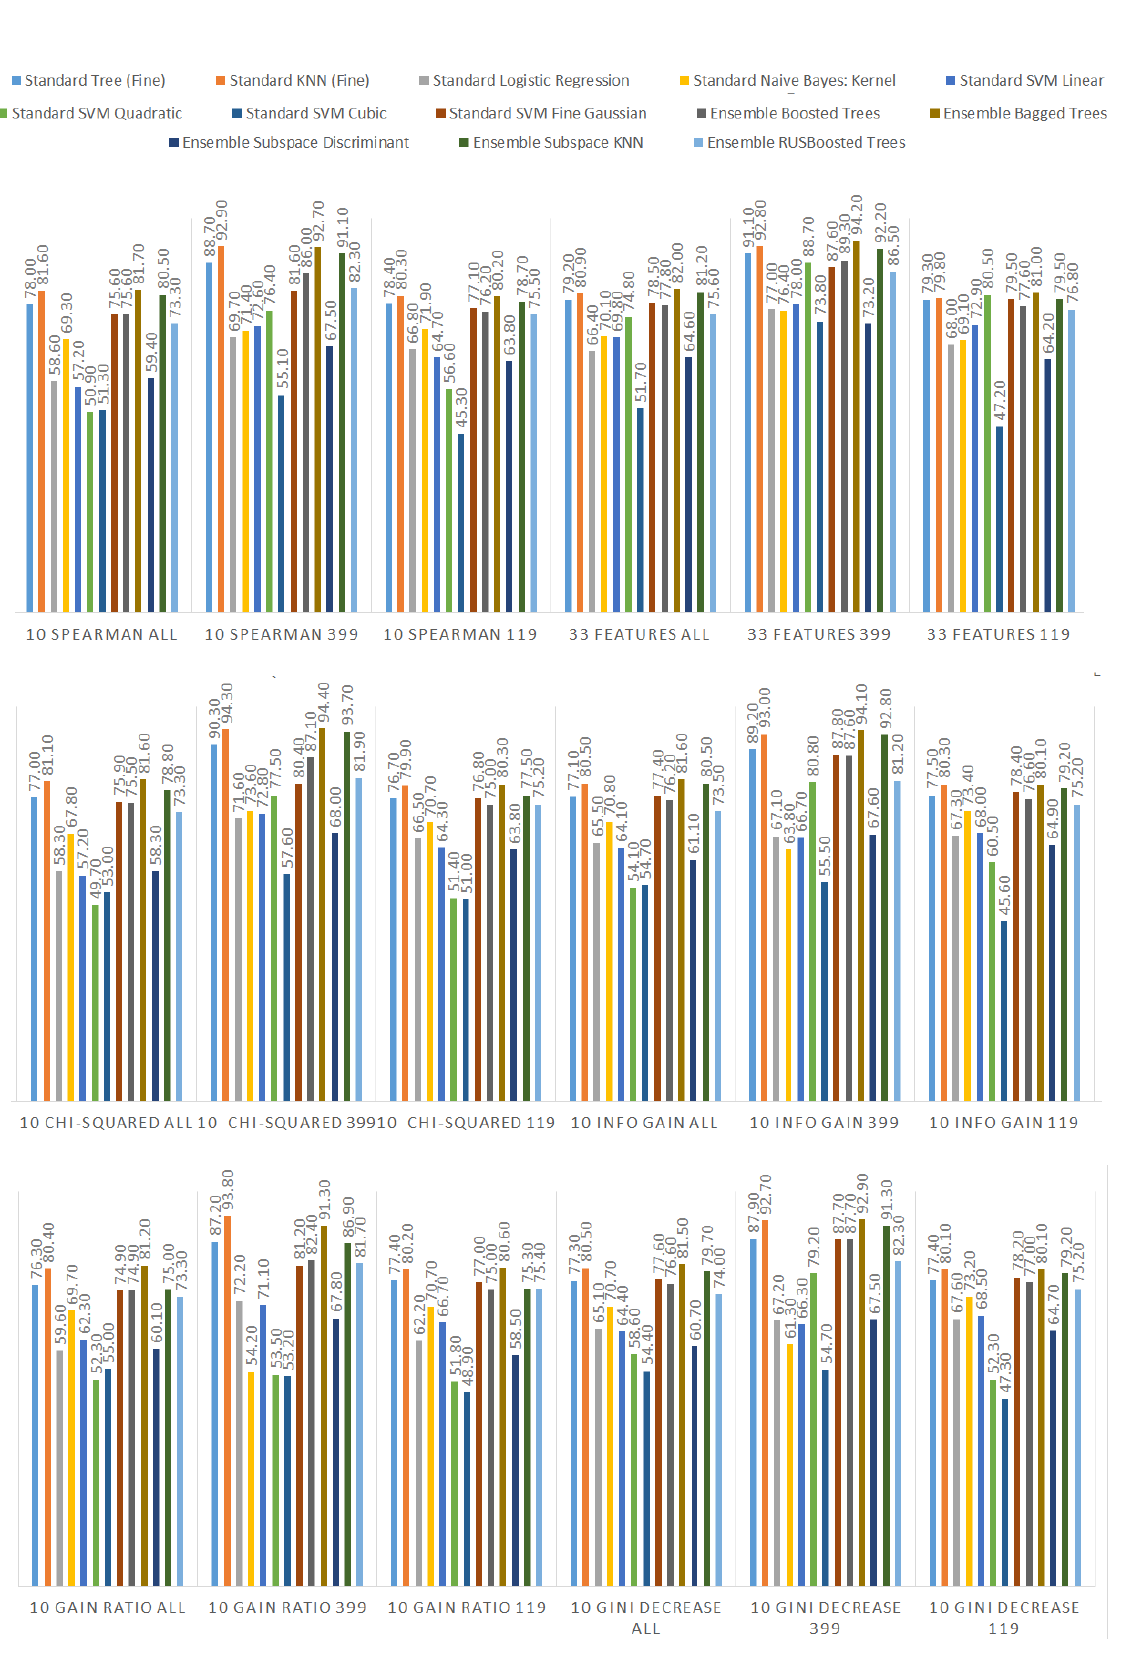
Figure 13. Detailed accuracy results for different types of